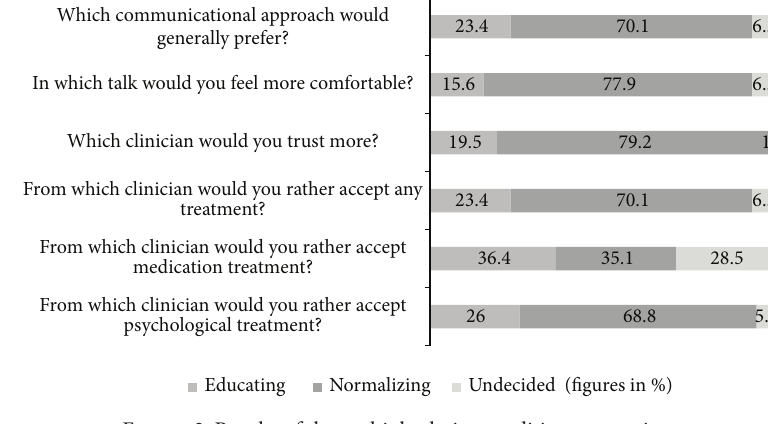
Figure 2: Results of the multiple choice condition comparison. Table 2: Analysis of the content of the open